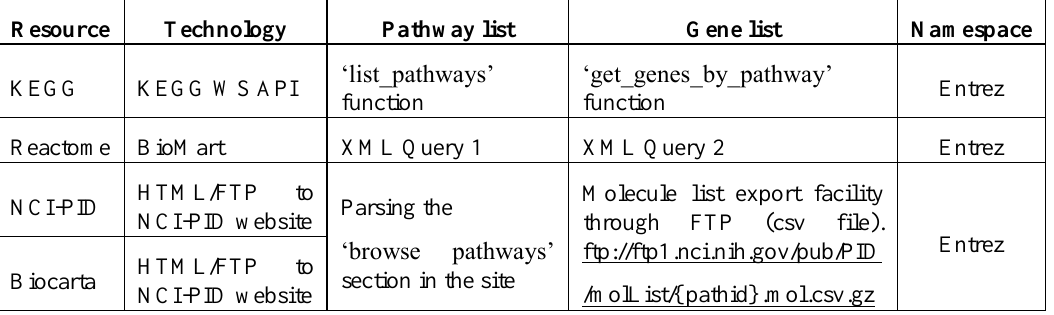
Table 2: External sources and accession methods used by PathJam for integrating pathway